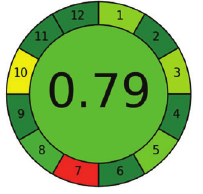
Fig. 6. Pictogram of an analytical method using AGREE